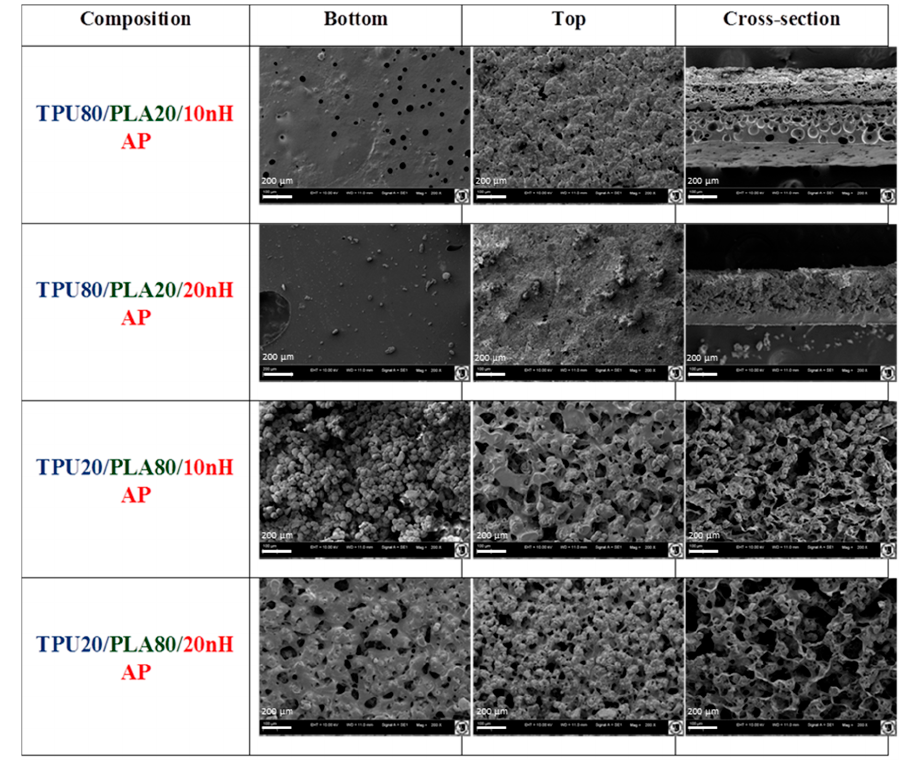
Figure 1. SEM image of the surface and cross-section of TPU/PLA/nHAp films, scale bar = 200 µm. Polymers 2016 , 8 , 339